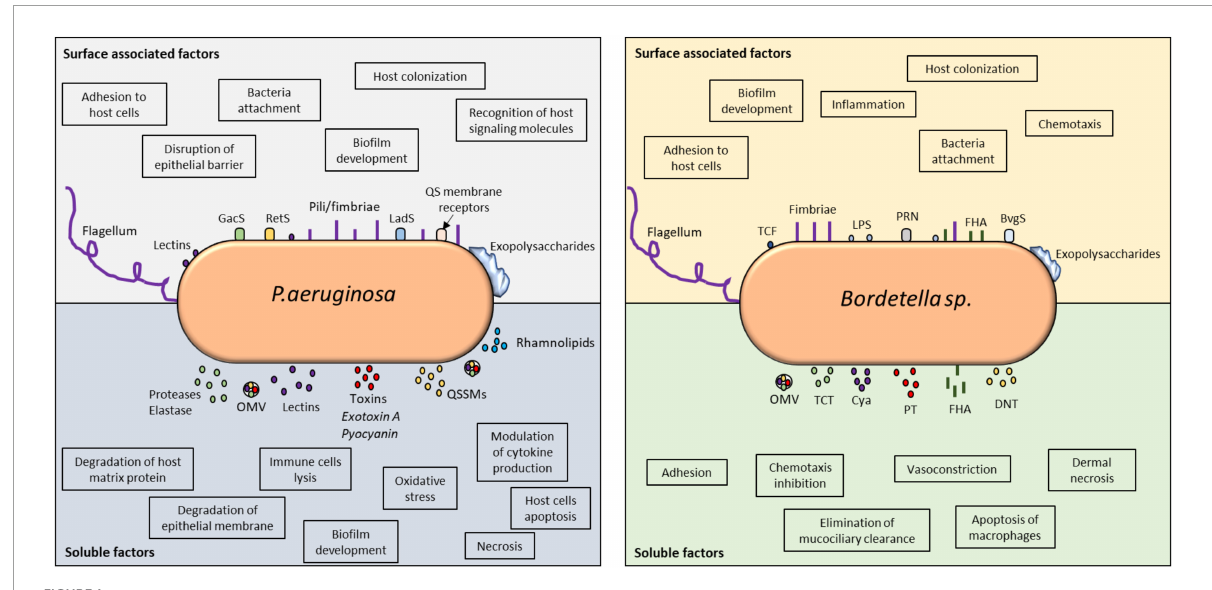
FIGURE1 Virulence factors involved in immune detection and evasion by P. aeruginosa and Bordetella spp. Comparative analysis of the surface-associated and soluble virulence factors of these two microorganisms revealed the utilization of classical adhesins for cellular attachment, host colonization, and invasion. The impact of their virulence factors on host immune modulation can be found in the highlighted boxes. Both microorganisms utilize TCSs to detect host signals and modulate their behavior. In P. aeruginosa, QS receptors can also detect host molecules, such as hormones and cytokines. Their soluble factors, especially toxins and lysins, are vital in host invasion and immune evasion because they control inflammation and can kill immune cells. Biofilms produced by these microorganisms are highly controlled at the molecular level and responsible for persistent infection. QS, quorum sensing; OMV, outer membrane vesicle; QSSM, quorum sensing signaling molecule; PT, pertussis toxin; TCF, tracheal colonizing factor; Cya, adenylate cyclase; TCT, tracheal cytotoxin; DNT, dermonecrotic toxin; PRN, pertactin; FHA, filamentous